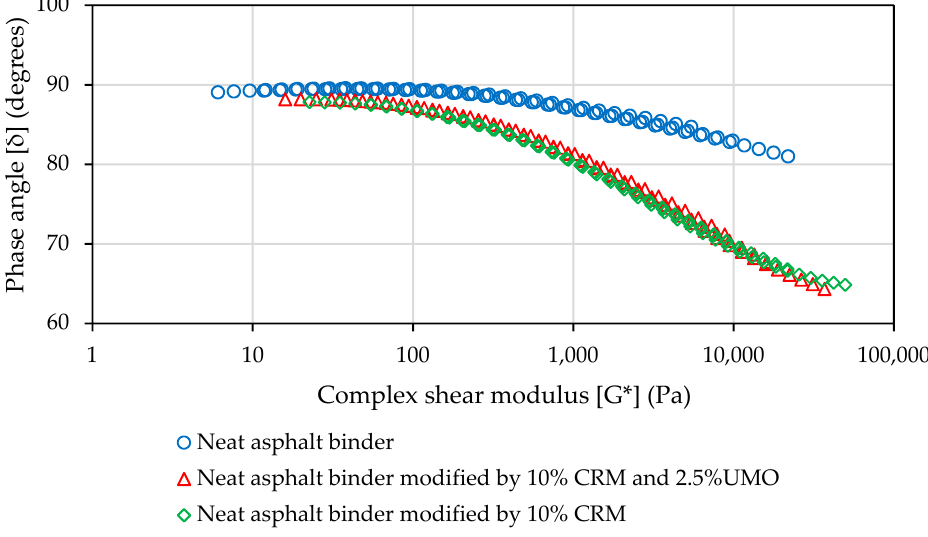
Figure 12. Black diagram for PG 64-22 neat and modified asphalt binders interacted at 190 ° C—50 Hz—62 min, measured at a reference temperature 60 °C.